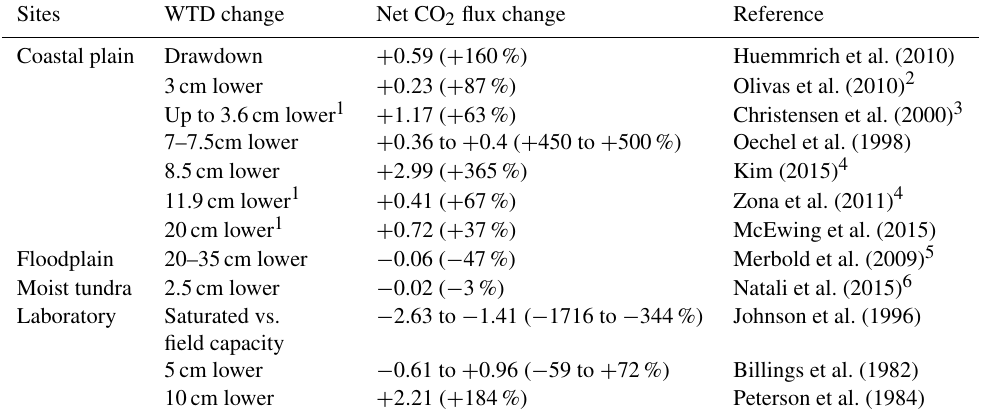
Table 1. CO 2 flux changes (g C-CO 2 m − 2 day − 1 ) in response to a WTD decrease, expressed as either flux control –flux lower-WTD or flux higher-WTD –flux lower-WTD . Negative net CO 2 flux rates represent a net increase in terrestrial CO 2 uptake; positive changes denote a decrease in net CO 2 uptake by the terrestrial ecosystem or an increase in terrestrial CO 2 emissions to the atmosphere. The ranges of these changes are from different years, soil types, and study sites. Numbers in parentheses represent percent change compared to the original (control, WTD condition)